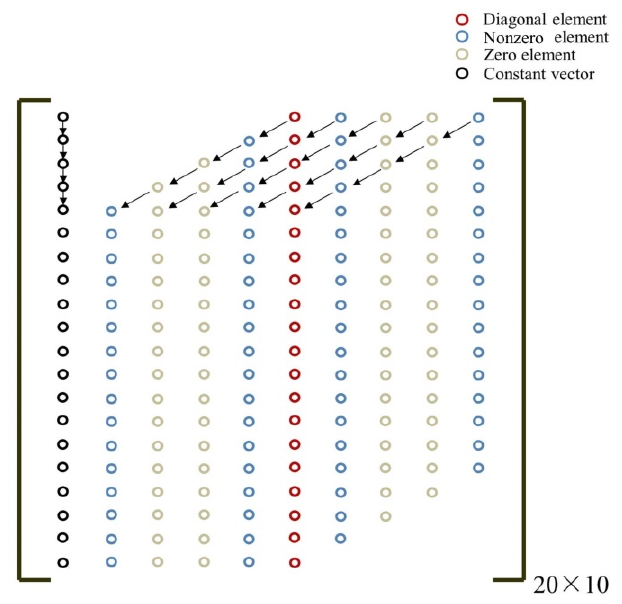
Figure 7. Elimination process of the augmented matrix A .